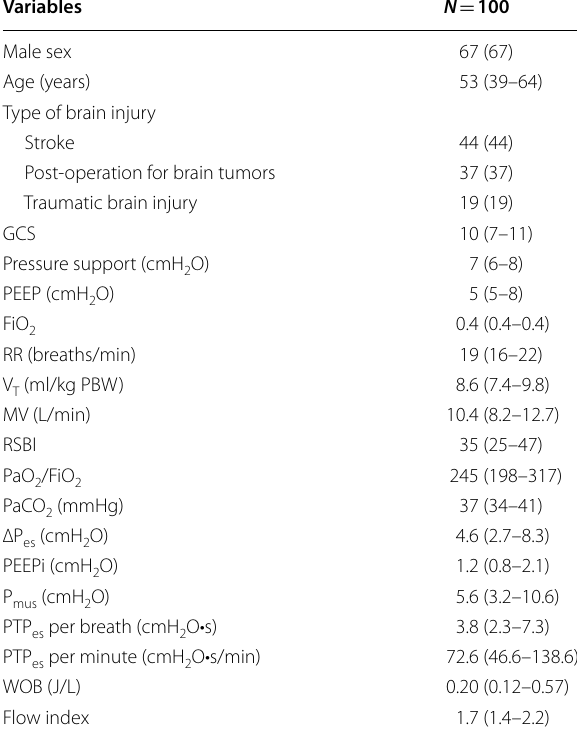
Table 1 Patients’